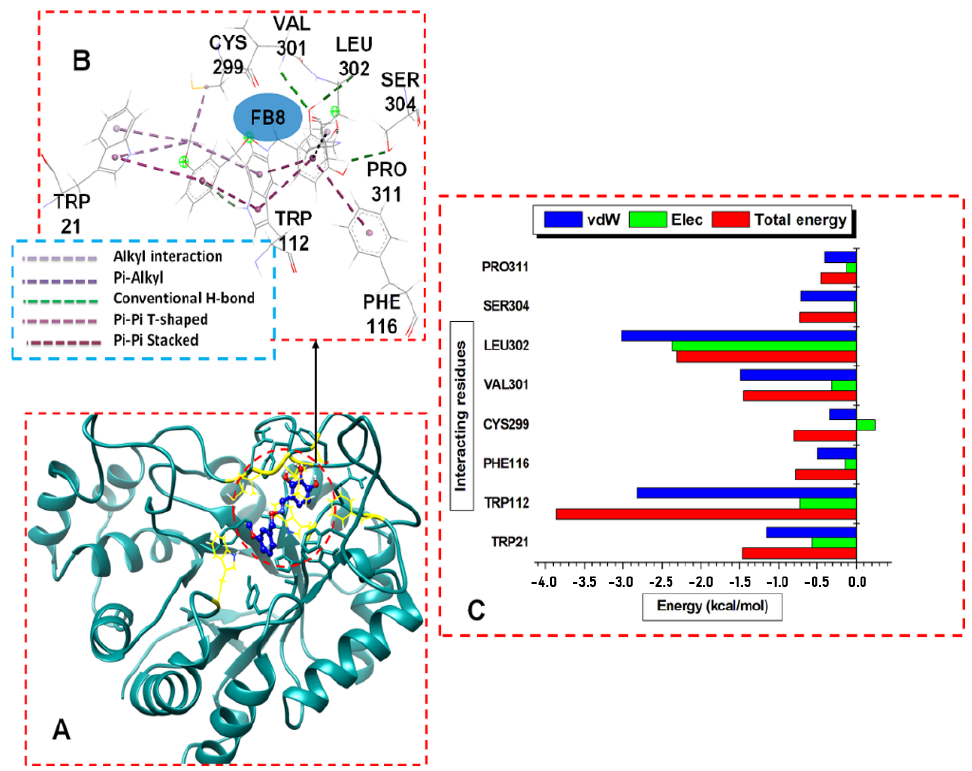
Figure 6. ( A ) Structural view of 7b (working code FB8) bound to ALR2 enzyme active site. ( B ) Visual illustration of the ALR2- 7b interaction network (color online). ( C ) Per-residue energy contributions to the ALR2- 7b complex.